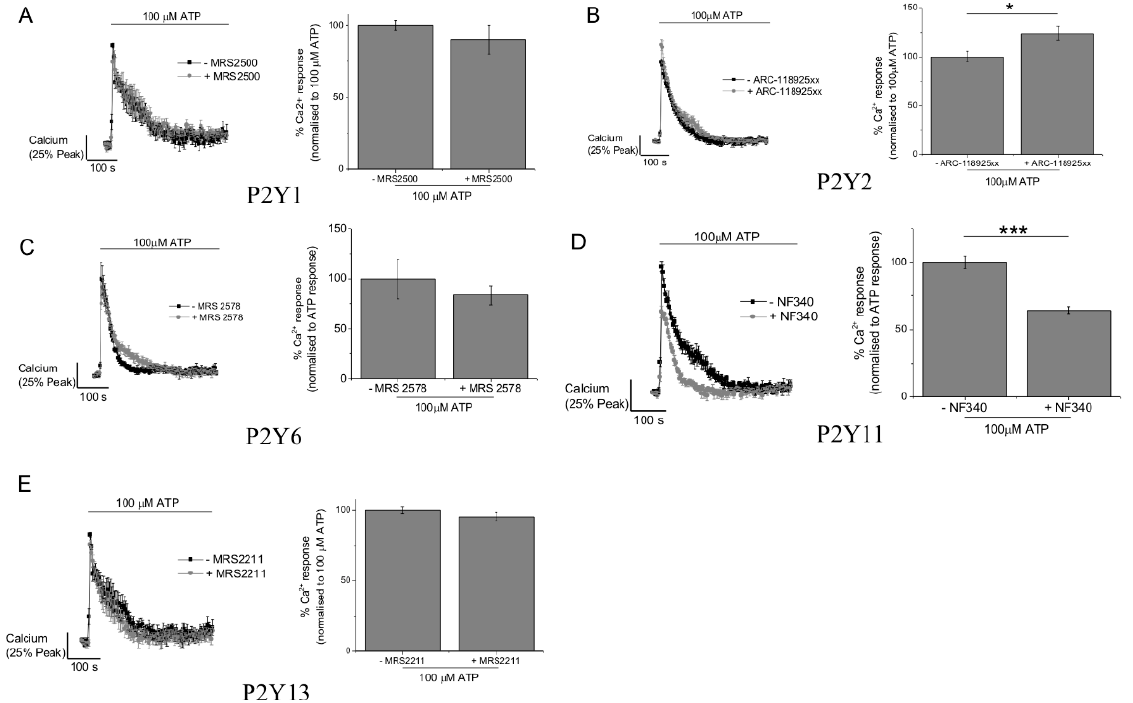
Figure 5. Effect of antagonizing P2Y receptor subtypes on ATP-evoked Ca 2+ responses in M-CSF Figure 5. E ff ect of antagonizing P2Y receptor subtypes on ATP-evoked Ca 2 + responses in M-CSF differentiated macrophage. For all panels ( A – E ), average Ca 2+ response traces ( N = 3) are shown to the di ff erentiated macrophage. For all panels ( A – E ), average Ca 2 + response traces ( N = 3) are shown left, with and without antagonist, and quantitated peak Ca 2+ responses are shown in the bar chart to to the left, with and without antagonist, and quantitated peak Ca 2 + responses are shown in the bar the right. Effects of receptor antagonism are shown for ( A ) P2Y1 (MRS2500, 1 μ M), ( B ) P2Y2 (ARC- chart to the right. E ff ects of receptor antagonism are shown for ( A ) P2Y1 (MRS2500, 1 µ M), ( B ) P2Y2 118925XX, 10 μ M), ( C ) P2Y6 (MRS2578, 10 μ M), ( D ) P2Y11 (NF340, 10 μ M), and ( E ) P2Y13 (MRS2211, (ARC-118925XX, 10 µ M), ( C ) P2Y6 (MRS2578, 10 µ M), ( D ) P2Y11 (NF340, 10 µ M), and ( E ) P2Y13 10 μ M). * p < 0.05; *** p < 0.01. All data is mean ± SEM; hypothesis testing by t -test. (MRS2211, 10 µ M). * p < 0.05; *** p < 0.01. All data is mean ± SEM; hypothesis testing by t